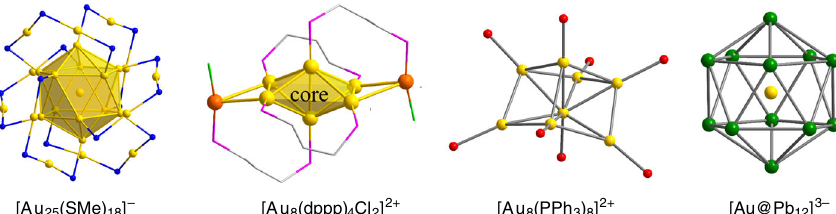
Fig. 1 Structures of Au-containing clusters. Structural features of selected gold-containing clusters, [Au 25 (SMe) 18 ] − , [Au 8 (dppp) 4 Cl 2 ] 2 + , [Au 8 (PPh 3 ) 8 ] 2 + and [Au@Pb 12 ] 3 − . dppp =